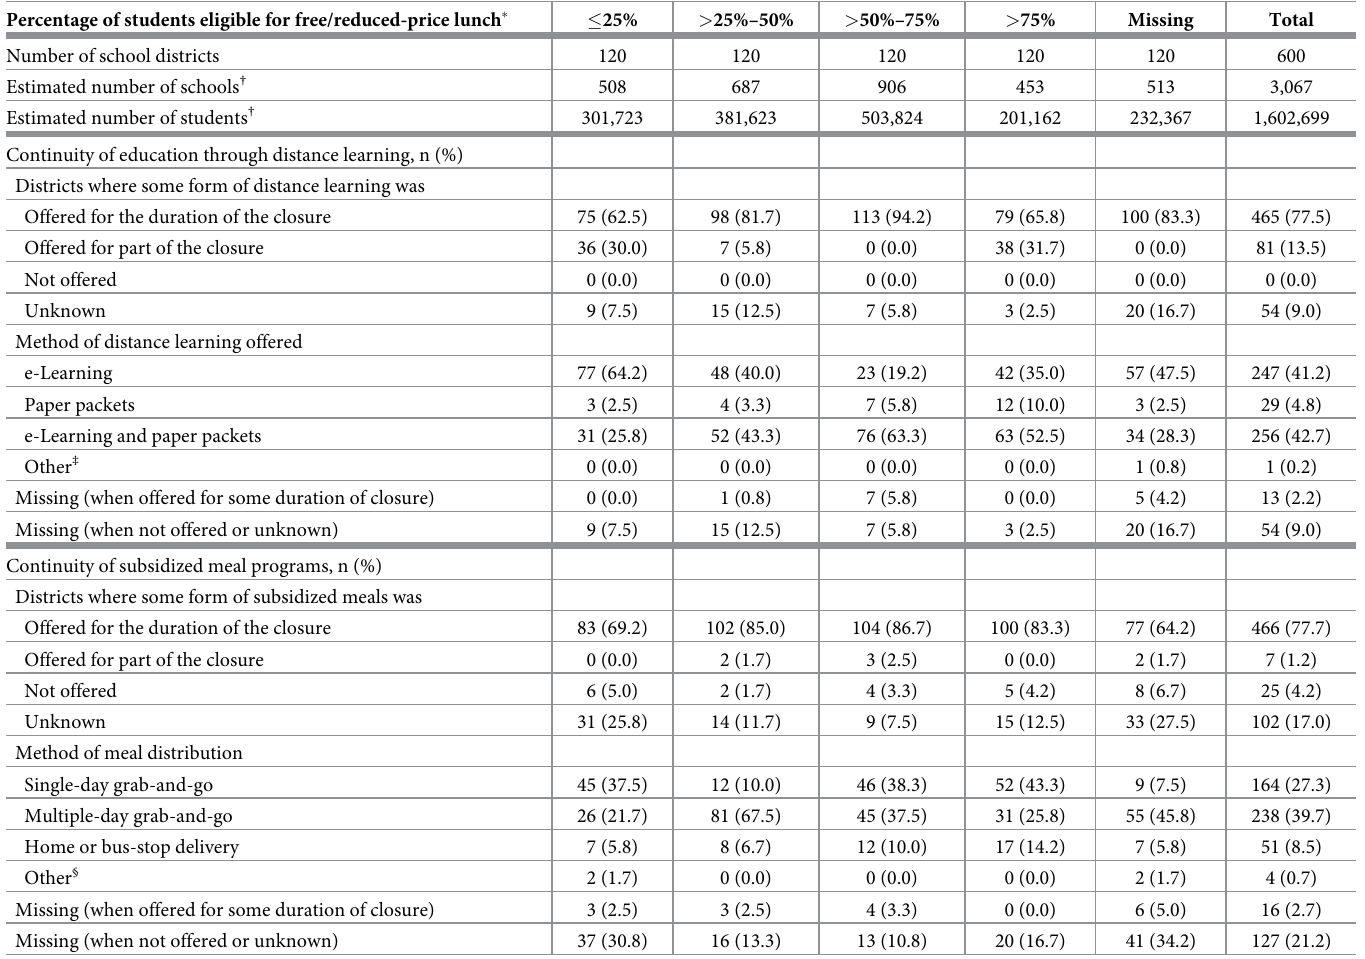
Table 2. Characteristics of sampled school districts (N = 600) describing the continuity of distance learning and subsidized meal programs during prolonged school closures due to the coronavirus disease 2019 pandemic—United States, March–May 2020. Percentage of students eligible for free/reduced-price lunch